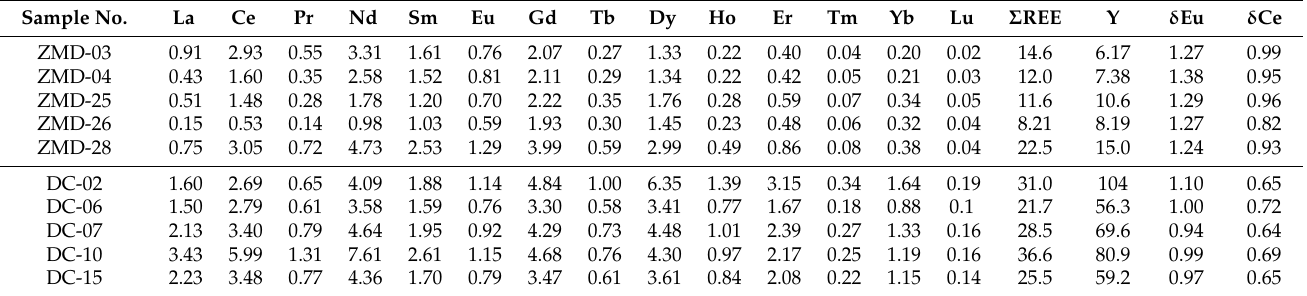
Table 1. Rare earth element (REE) compositions ( µ g/g) of the calcite and fluorite samples. Sample No.